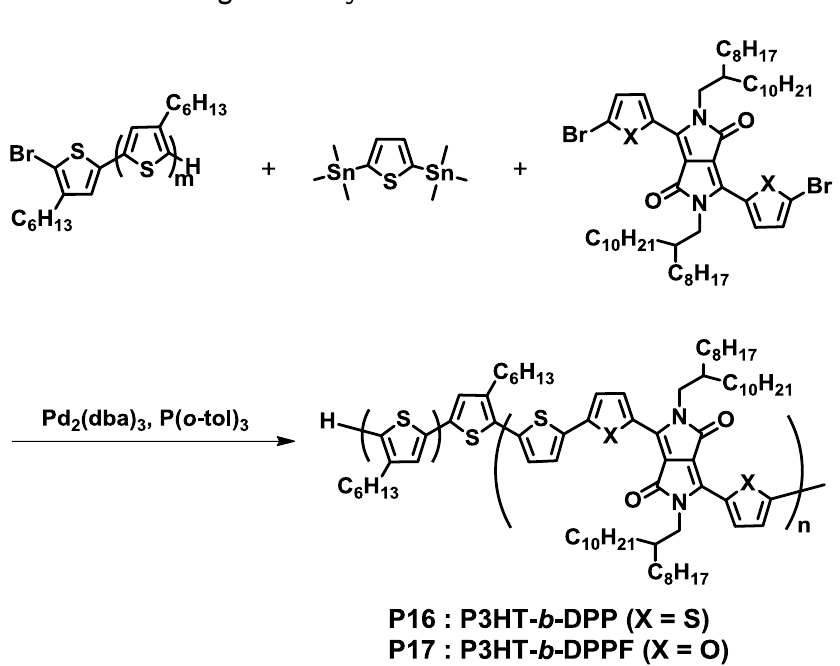
Figure 13. Synthesis of P16 and P17 .